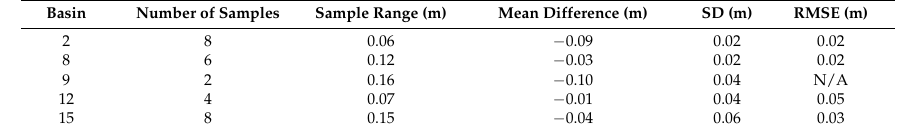
Table 5. Water-surface measurement comparison to Lidar-derived surface returns ( d Z = h L − h g ).